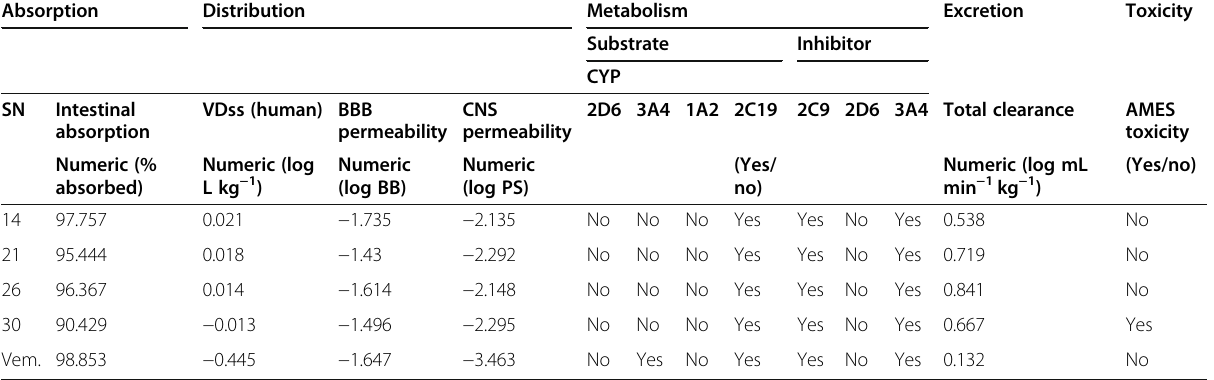
Table 6 Predicted the pharmacokinetic properties of the selected compounds Absorption Distribution